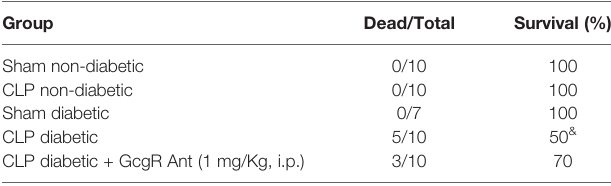
CLP was performed 21 days after alloxan-induced-diabetes, and the treatment with GcgR antagonist (1 mg/Kg, i.p.) was carried out 24h and 1h before CLP. The survival rate was evaluated from 0 to 24h after induction of sepsis through CLP. CLP, Cecum ligation and puncture; GcgR Ant, GcgR Antagonist. & P < 0.05 compared to CLP non- diabetic